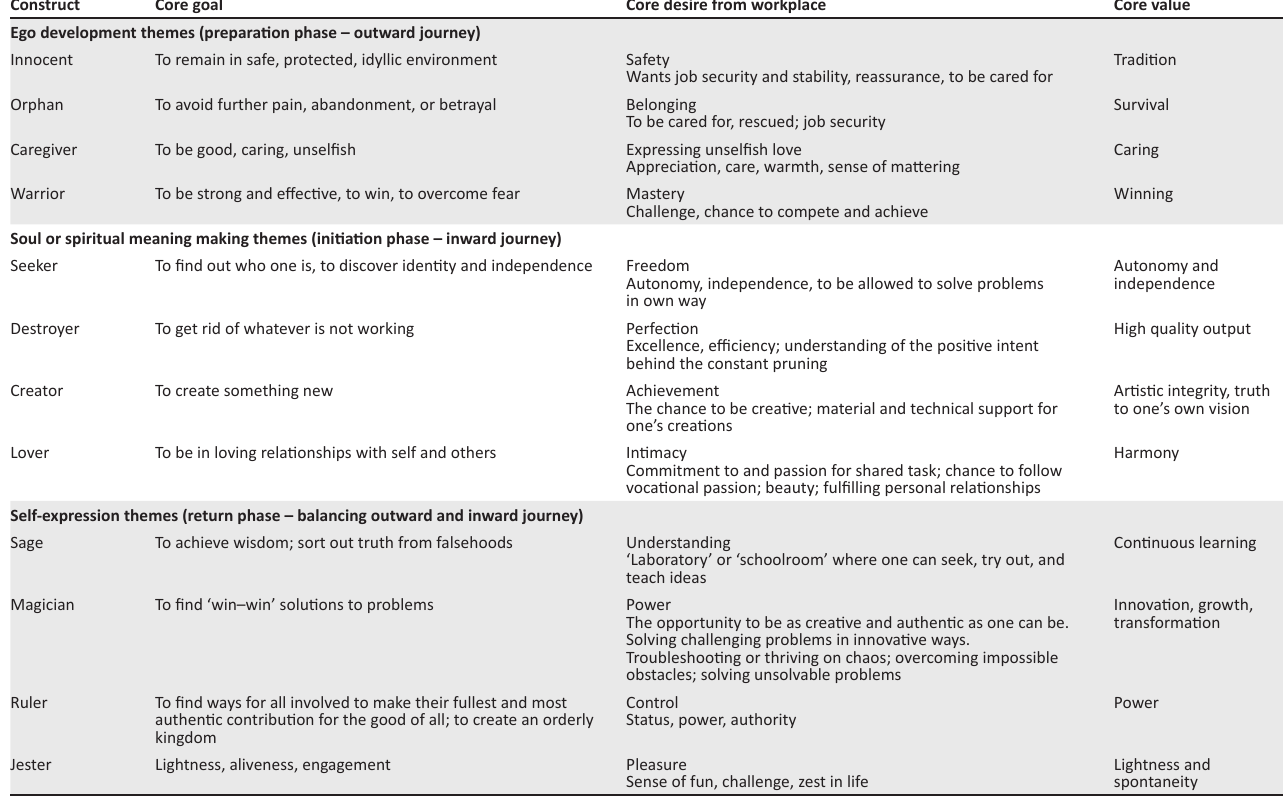
TABLE 1: Core underlying goals, desires and values underlying Pearson’s (1997) archetypal life themes (Coetzee, 2012).